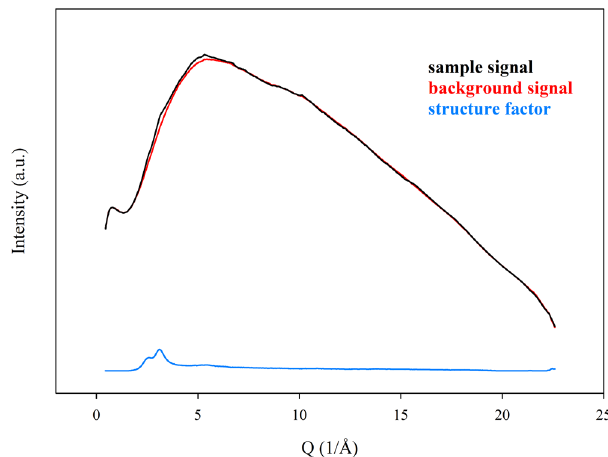
Fig. 5 Graphical representation of the procedure to derive the structure factor from experimental data. The background signal (in red) is subtracted from the sample signal (in black) and the difference is the structure factor S( Q ) (in blue). The selected signal was acquired at 46 GPa, while the background was measured at 1 bar using the same gasket, thus same distance between the diamonds, after the sample has been decompressed, removed, and the gasket cleaned in ultrasonic